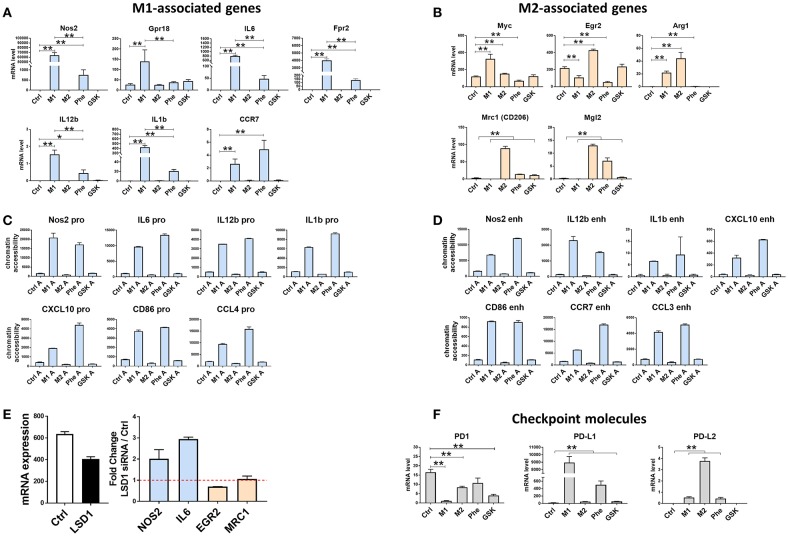
LSD1 can regulate genes associated with macrophage polarization toward an M1 phenotype and checkpoint molecules. RAW264.7 cells were untreated or treated with LPS + IFN-γ (M1), IL-4 (M2), or 500 μM of phenelzine or GSK for 24 h. Quantitative real-time PCR of genes associated with (A) M1-associated genes and (B) M2-associated genes were used to compare different treatment groups. Graphs are represented as mRNA levels normalized to GAPDH. Graphs show means ± SE (n = 3). *p < 0.05, **p < 0.005 Mann-Whitney t-test. (C) and (D) shows chromatin accessibility of genes in the promoter (C) and enchancer (D) regions of associated genes using quantitative real-time PCR using FAIRE samples. (E) 10nM LSD1 siRNA transfected cells and (F) checkpoint molecules and were used to compare different treatment groups.